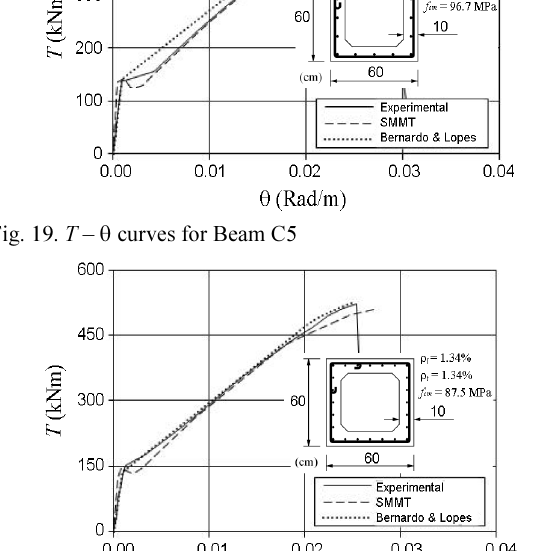
Fig. 23. T – θ curves for Beam